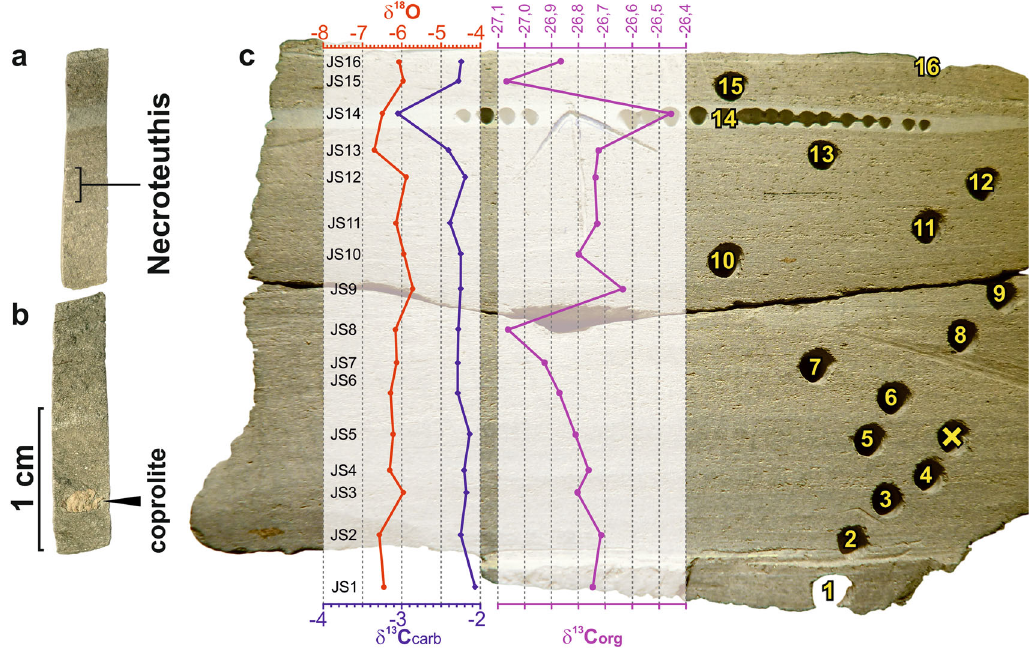
Fig. 5 Transect trough the gladius-bearing sediment (scale bar = 1 cm) in relation to stable isotope data of the δ 18 O carb , δ 13 C carb , and δ 13 C org . a Upper part with position of the gladius level (equals to JS12, probe no. 12). b Lower part with a phosphatized coprolite. c Positions of probes used for geochemistry. Sample no. 14 (JS14) with markedly different both δ 13 C isotope values is represented by light-gray mudstone